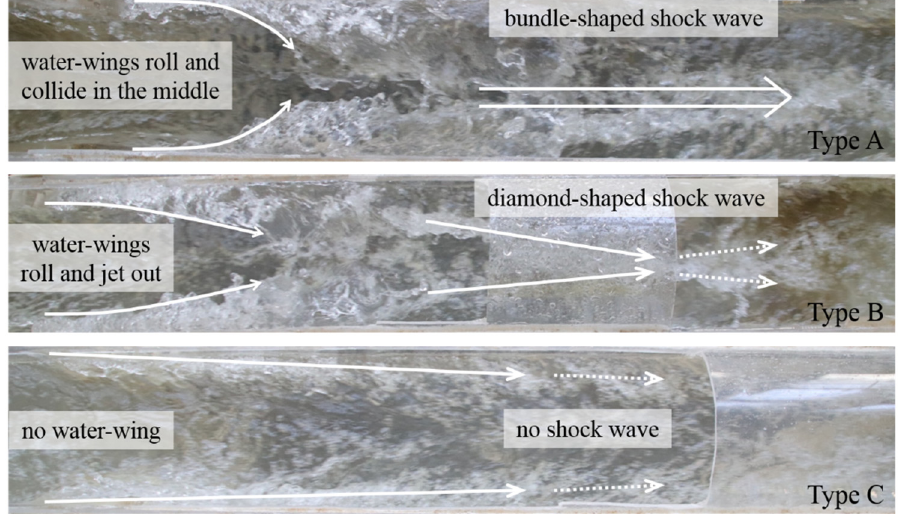
Figure 6. Top view of the flow pattern downstream of the deflectors.